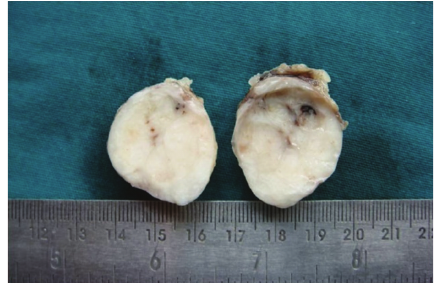
Figure 3: Excised gross cut section of the fibroadenoma.